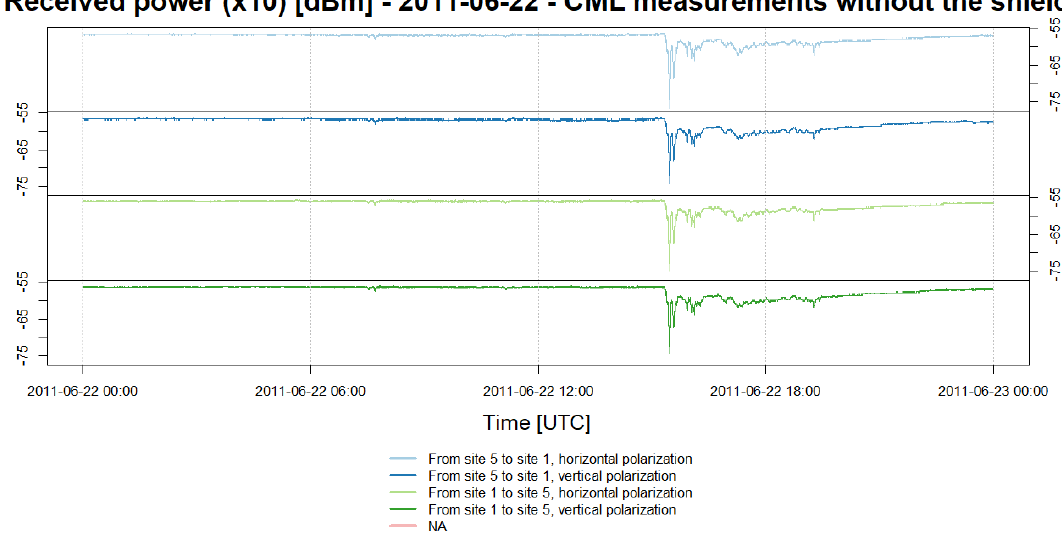
Figure 3. Example of measured received power for 22 June 2011 when antennas were not shielded. Green colours label the direction from site 1 to site 5 (D → W) and blue W → D. Light colours depict horizontal polarizations, and dark colours depict vertical polarization. Vertical red lines indicate NA values (not present during this event).